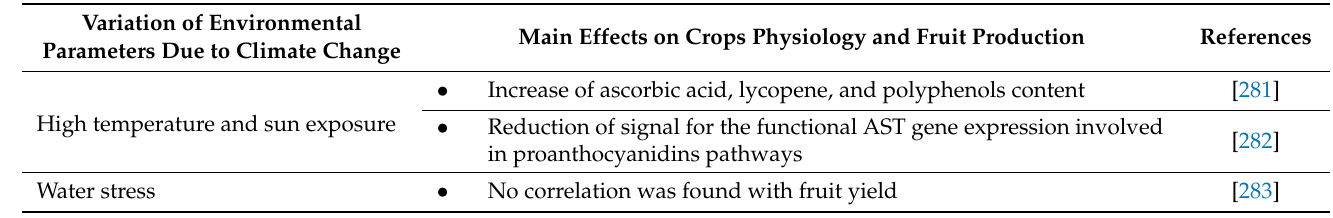
Table 6. Summary of principal effects of environmental conditions variation on Persimmon species.